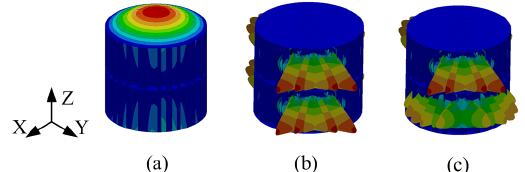
Figure 17. Simulated mode shapes for the D 2 -type panel: ( a ) mode at 5787 Hz; ( b ) mode at 7338 Hz; ( c ) mode at 7339 Hz.